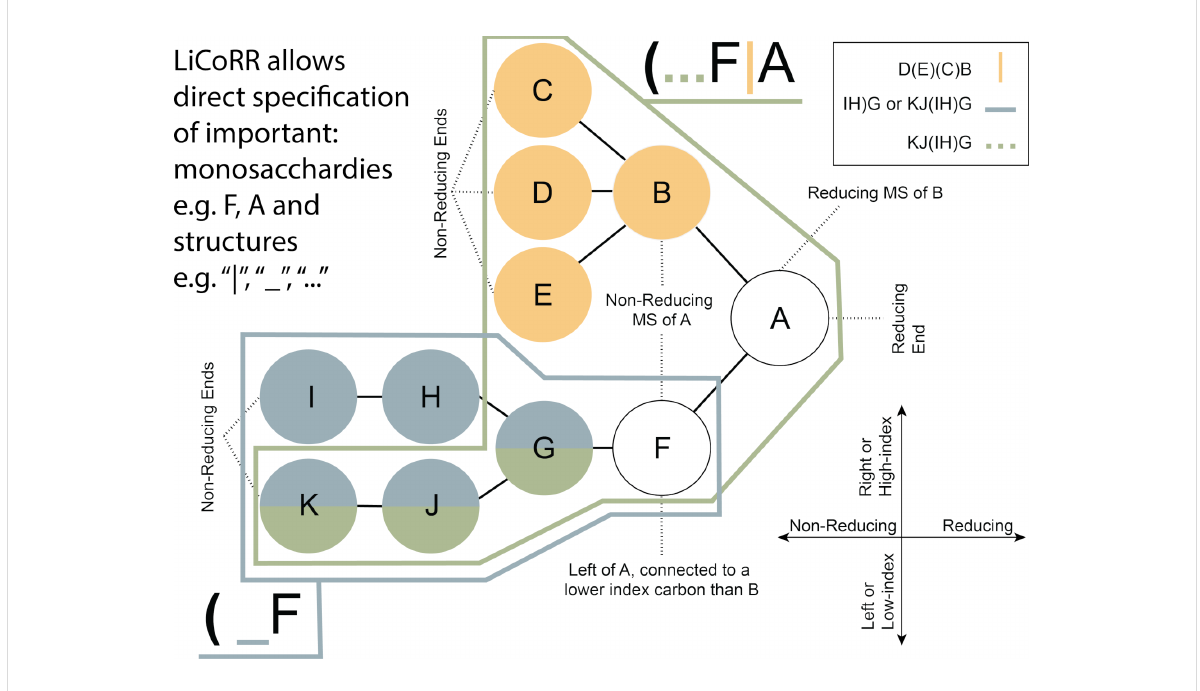
Figure 1: Common terminology and anatomy of a theoretical glycan, (KJ(IH)GF(D(E)(C)B)A. In this figure, we demonstrate some key terminology as well as the three primary uncertainty operators: branch (orange), continuation (blue), and ligand (green). The structures matching these terms are shown in matching colors, those matching both the continuation and ligand are shown in purple. A ligand can typically be removed with one cut. A continuation is a connection from a node to a root that can “continue” or “bypasses” other branch points. The paths from I to G or K to G represent one continuation; to represent both paths, a continuation is necessary because traversing from I to G requires the syntactic “bypass” of the KJ